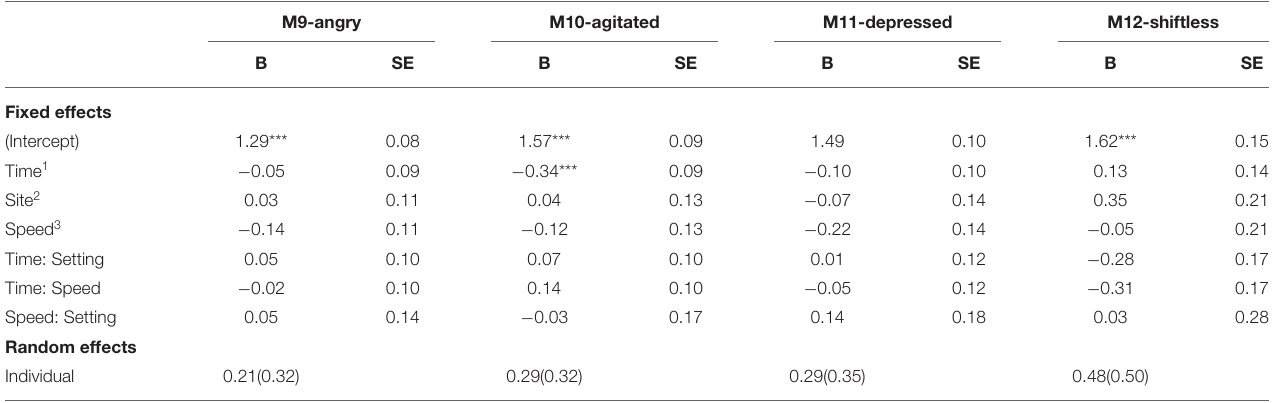
TABLE 5 | Multilevel modeling results for the effects of walking conditions on the negative moods 4 .